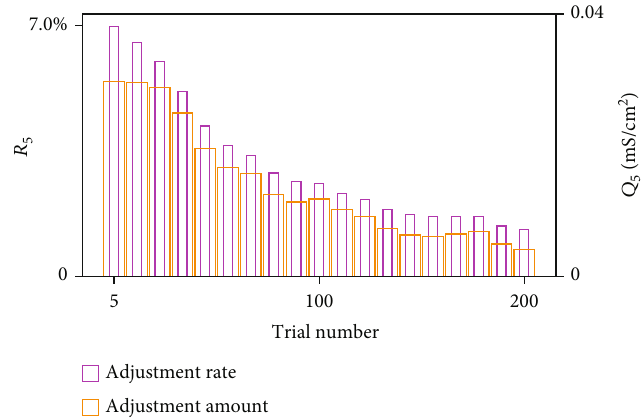
Figure 11: The mean adjustment of AFP every 5 trials during song learning. For fi ve trials, synaptic conductance was maximally adjusted with a growth rate of 7%, an increase of 0.04 mS/cm 2 . With an increasing number of trials, adjustment amount Q